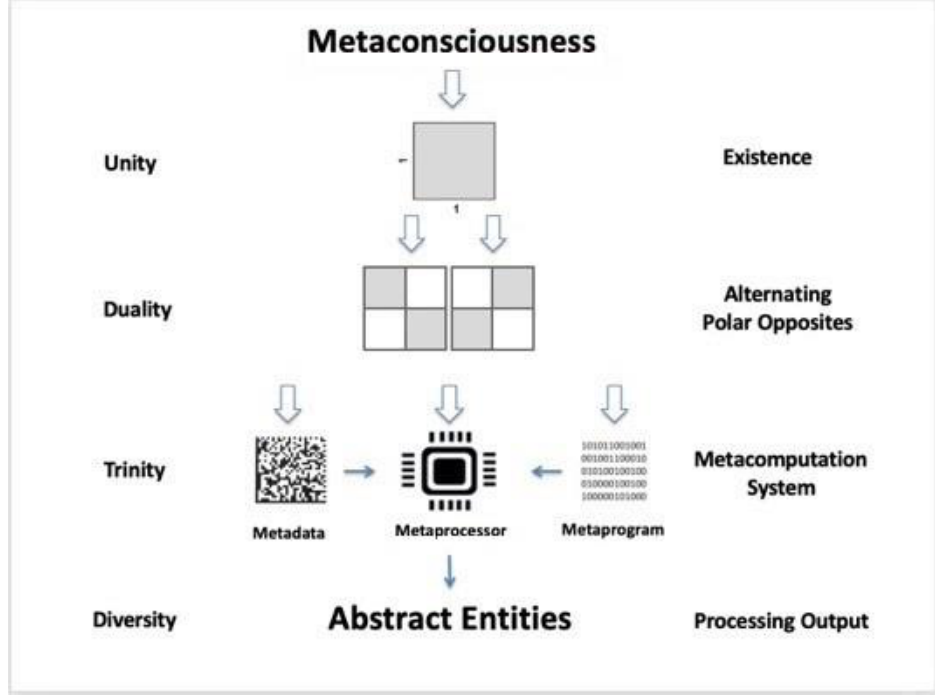
Figure 1. Construction of Platonic computer in the realm of forms